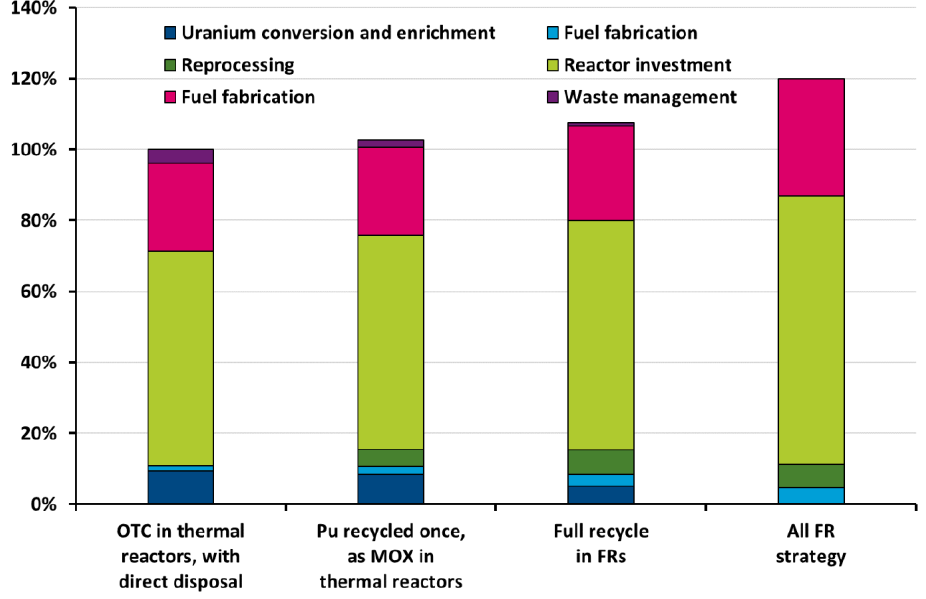
Figure 5. Cost estimates normalised to the OTC for various closed cycle options [4,59].